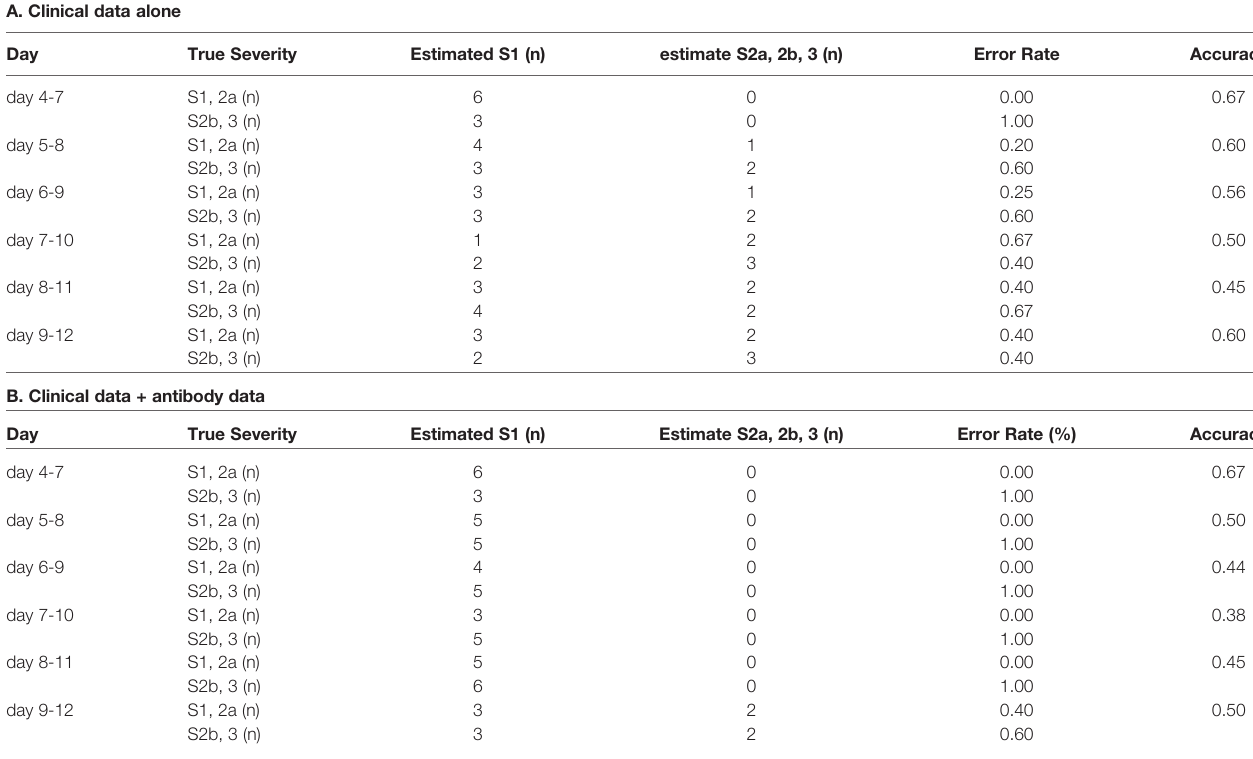
TABLE 4 | The accuracy of the model to distinguish severity groups 2b and 3 from severity groups 1 and 2a in the cases of breakthrough